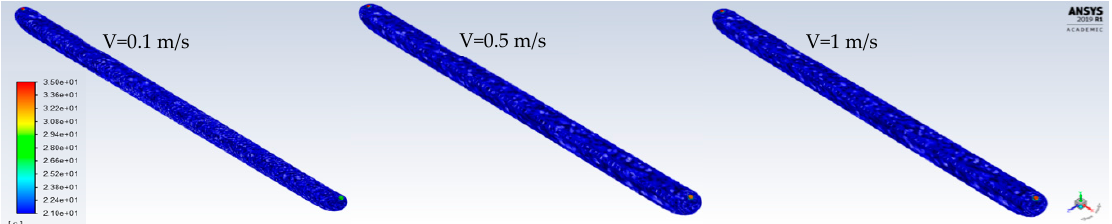
V=0.5 m/s V=0.1 m/s V=1 m/s